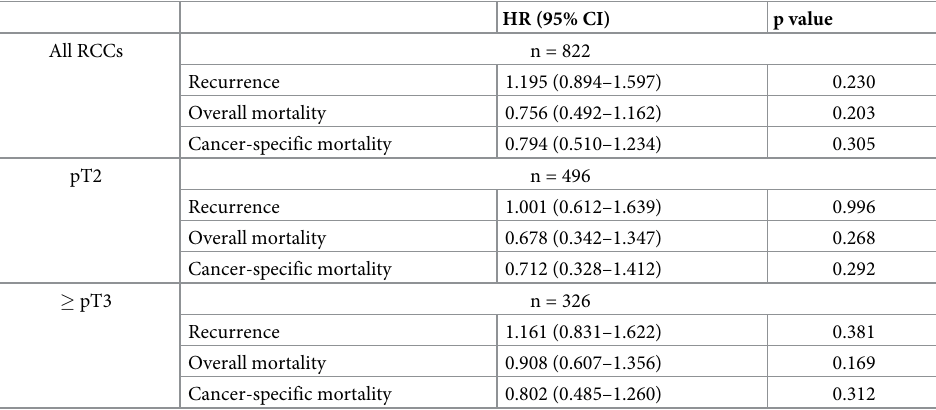
Survival outcomes between the LRN and ORN groups were compared separately in each subgroups according to the pathologic stage of RCC. When we performed Kaplan-Meier anal- ysis of the 496 patients with pathologic stage of pT2, we found no significant difference between the LRN and ORN groups in terms of PFS (p = 0.984), OS (p = 0.186), or CSS (p = 0.243). Further analyses of the 326 patients with the higher pathologic stage ( (cid:21) pT3) also did not show any significant difference in PFS (p = 0.111), OS (p = 0.427), or CSS (p = 0.690). Multivariate Cox proportional analyses also showed no significant relationships between surgi- cal approach and survival outcomes in subgroups according to the pathologic stage (Table 3). Furthermore, we compared postoperative complication rates between the LRN and ORN Table 3. Multivariate analyses using the Cox proportional hazard model of the association of surgical type (lapa- roscopic versus open nephrectomy) with survival outcomes. HR (95% CI) p value All RCCs n = 822